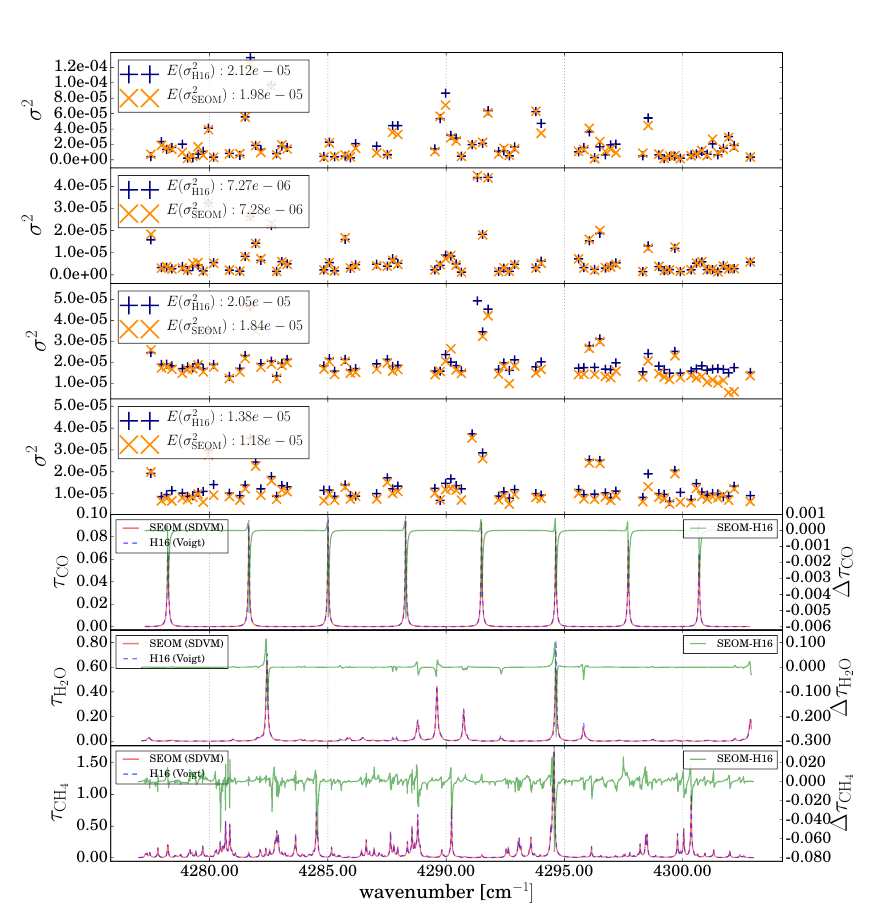
Figure 5. The upper four panels depict the average residual norm in April 2004 for each available SCIAMACHY pixel for the regions Sahara, Amazonia, Siberia and CaPaAl, respectively. Gaps indicate bad pixels according to the DBPM. The lower three panels show the optical depths of the molecules CO, H 2 O and CH 4 for SEOM and H16 according to US-Standard along with their